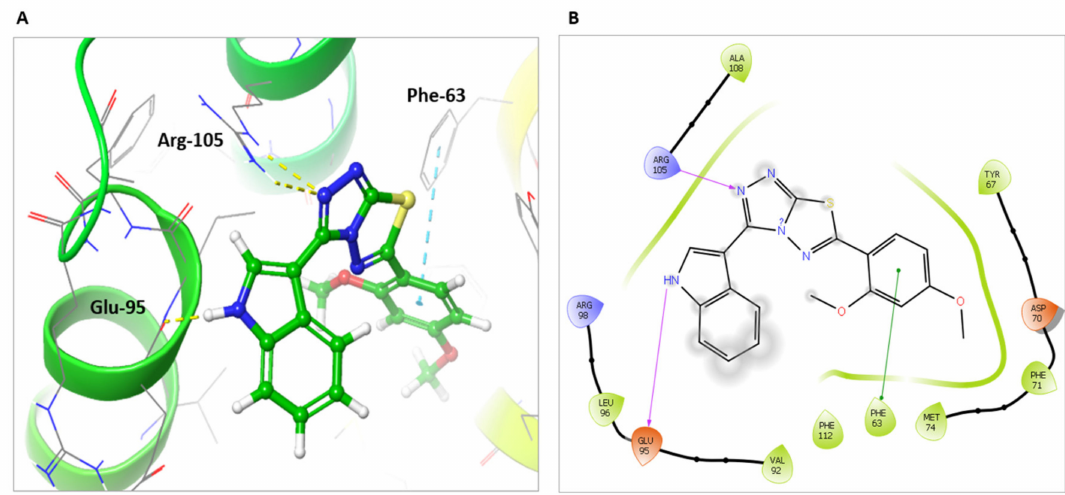
Figure 3. Molecular docking of 5k . ( A ) Interaction of 5k within the active site of Bcl-2 (PDB: 4AQ3) showed key interactions with Arg-105, Glu-95 and Phe-63. ( B ) Schematic diagram for ligand interaction of 5k